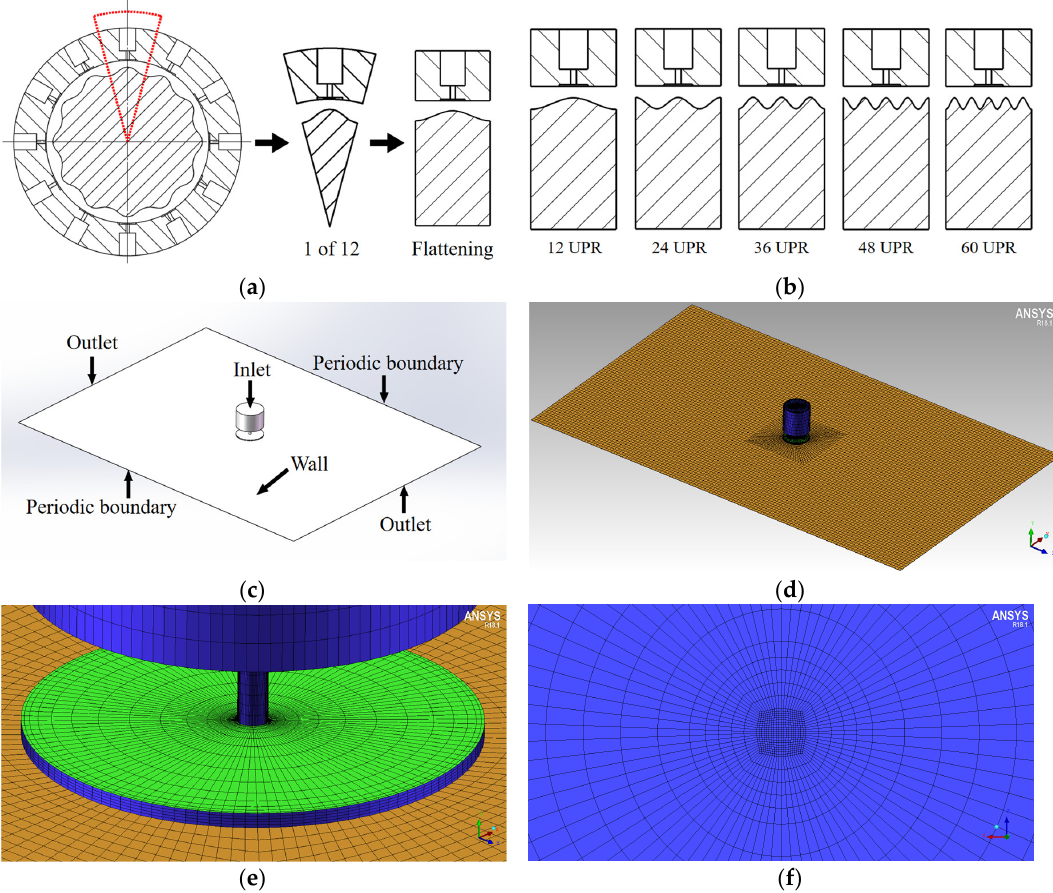
Figure 6. Preprocessing of CFD analysis: ( a ) schematic diagram of the simplified structure; ( b ) schematic diagram of outflow region with different error frequencies; ( c ) model of inner flow region and setting of boundary conditions; ( d ) global structured mesh by ICEM TM ; ( e ) inflation at the edge; ( f ) inflation at the orifice.